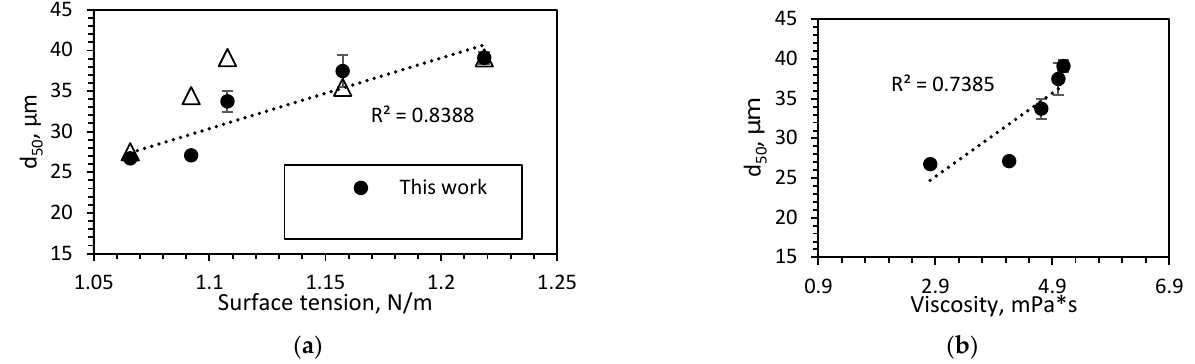
Figure 5. The effect of surface tension on d obtained in this work experimentally and calculated by Lubanska equation (Equation (1)) ( a ); and the effect of viscosity on the median particle size in present work ( b ).